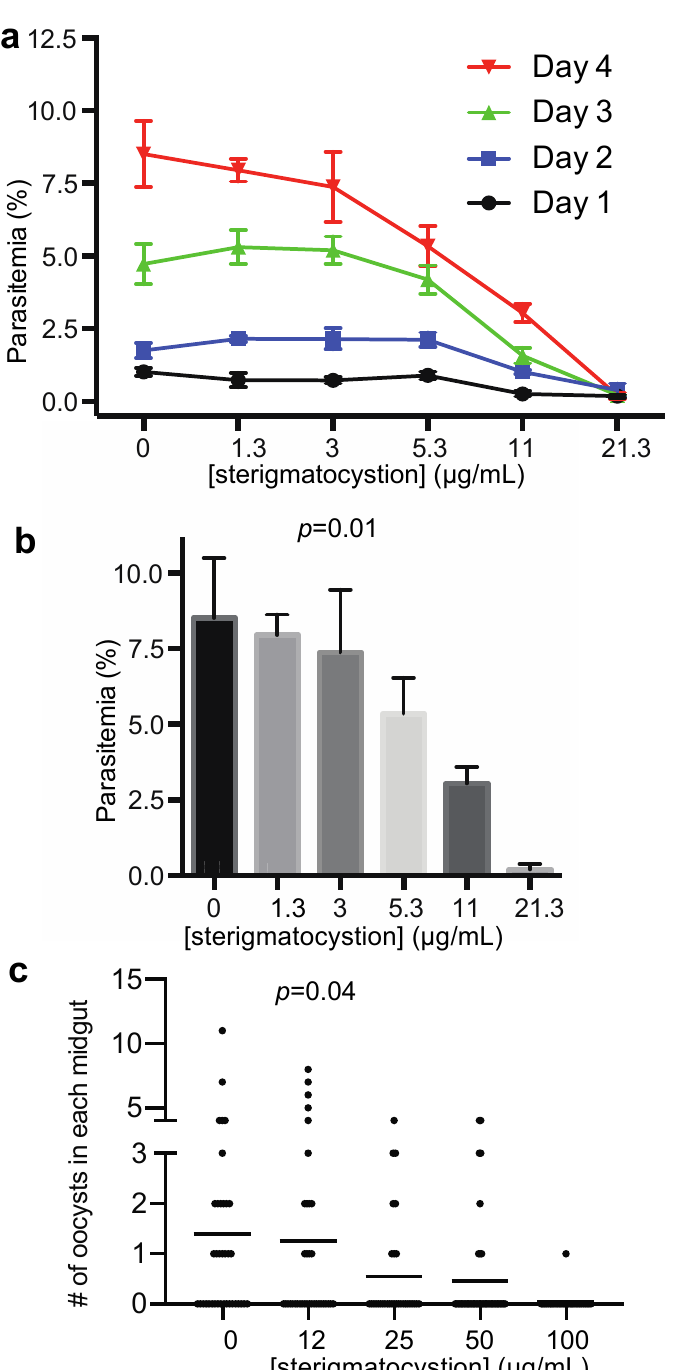
Figure 6. Sterigmatocystin inhibited P. falciparum infection in blood and transmission to An. gambiae . ( a ) Parasitemia at Day 1, 2, 3, and 4 after inoculation of different concentrations of compound. ( b ) Parasitemia on day 4 after incubated with different concentrations of compound. Significantly fewer P. falciparum -infected cells were observed when concentration of compound was greater than 11 µg/mL ( p < 0.05), compared to control (0 µg/mL). For data in ( a , b ), each concentration was replicated three times; profiles show means and standard errors; ( c ) compound significantly inhibited P. falciparum transmission to mosquitoes at concentration of 25 µg/mL or more, compared to that of control (0 µg/mL).